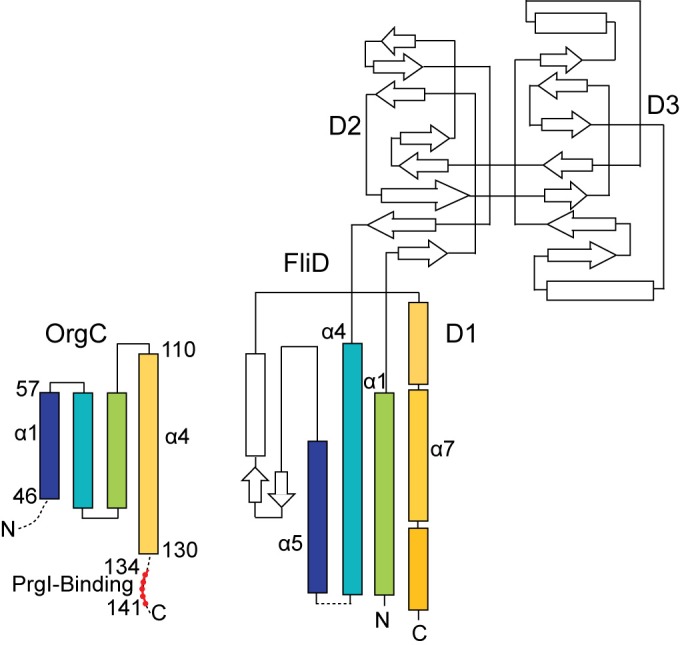
The topology of the OrgC fold shares similarity only partly with the topology of the FliD D1 domain.The OrgC fold is depicted similar to the topology fold of FliD as reported by Song et al (Song et al., 2017). Shown in colors are the similarity in the folding topology of OrgC and FliD.